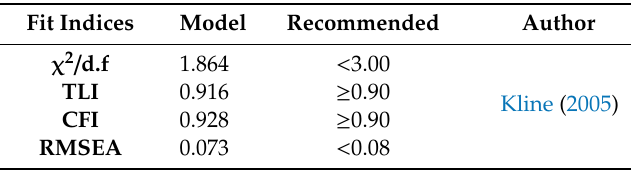
Table 6. Measurement model fitting indices.